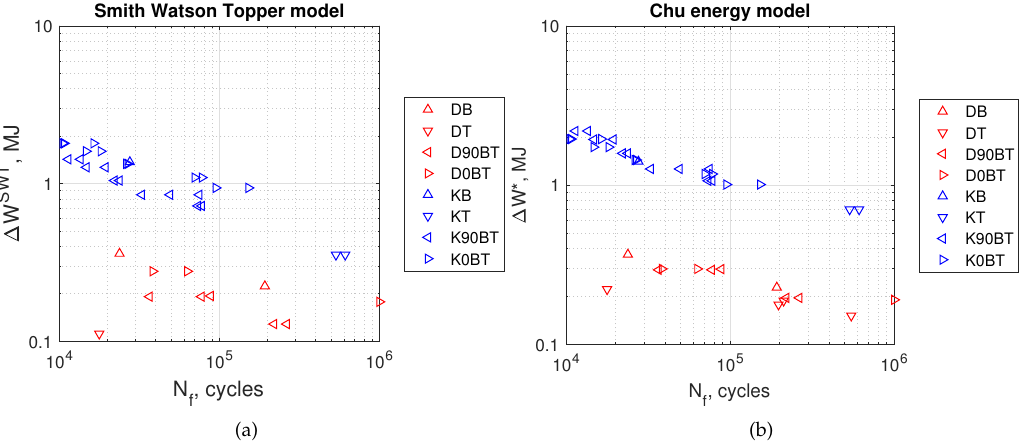
Figure 13. ( a ) Smith Watson Topper model in Equation (5), ( b ) Chu model in Equation (6). Tests at kinematic load: K90BT, out of phase; K0BT, in phase; KB, bending; KT, torsion. Dynamic loads: D90BT, out of phase; D0BT, in phase; DB, bending; DT, torsion.